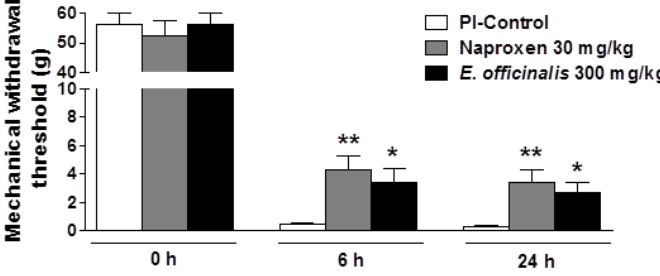
Figure 1. Effect of Emblica officinalis extracts on mechanical hypersensitivity induced by plantar incision in rats. Baseline assessment of animals before surgery (day 0) showed no significant variation between groups. At 6 h or 24 h after PI, rats treated with E. officinalis extracts demonstrated significantly attenuated hypersensitivity in response to von Frey stimulation of the injured hind paw. Data are mean ± SEM ( n = 9 per group). * p < 0.05 and ** p < 0.01, significant difference from the control group. PI ‐ Control: